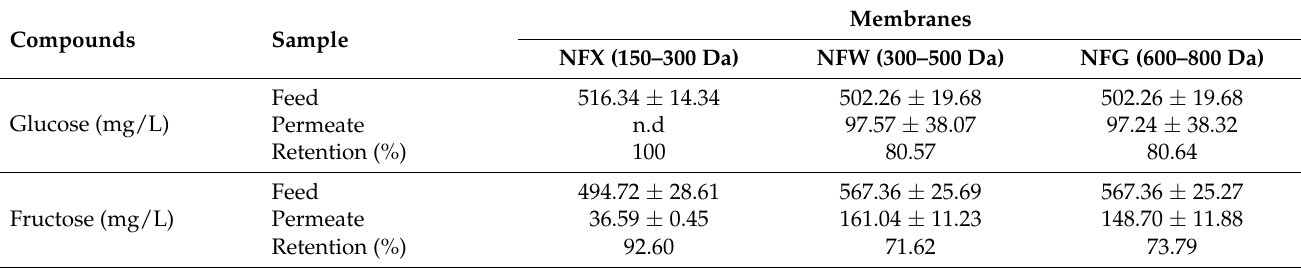
Table 3. Glucose and fructose content in the feed and permeate stream for investigated NF membranes after 180 min of